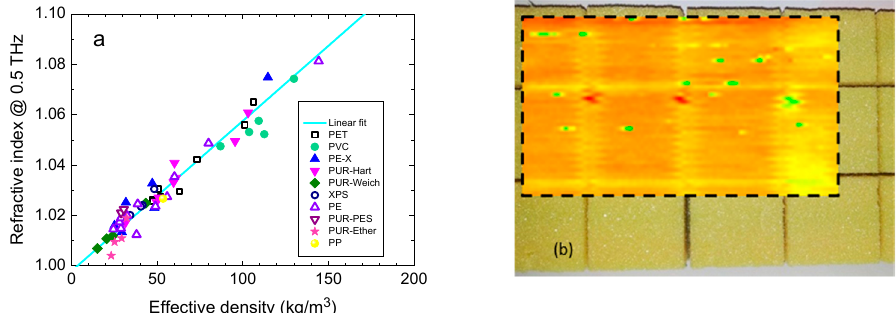
Figure 7. ( a ) Relation between refractive index and effective density for various polymer foams. Adapted from [49], courtesy of M. Mayr, S ű ddeutsches Kunststoffzentrum. ( b ) Photograph and THz transmission image (100 mm × 60 mm) of a 20 mm-thick piece polyvinyl chloride foam, as used in rotor blades. Courtesy of TOPTICA Photonics AG.